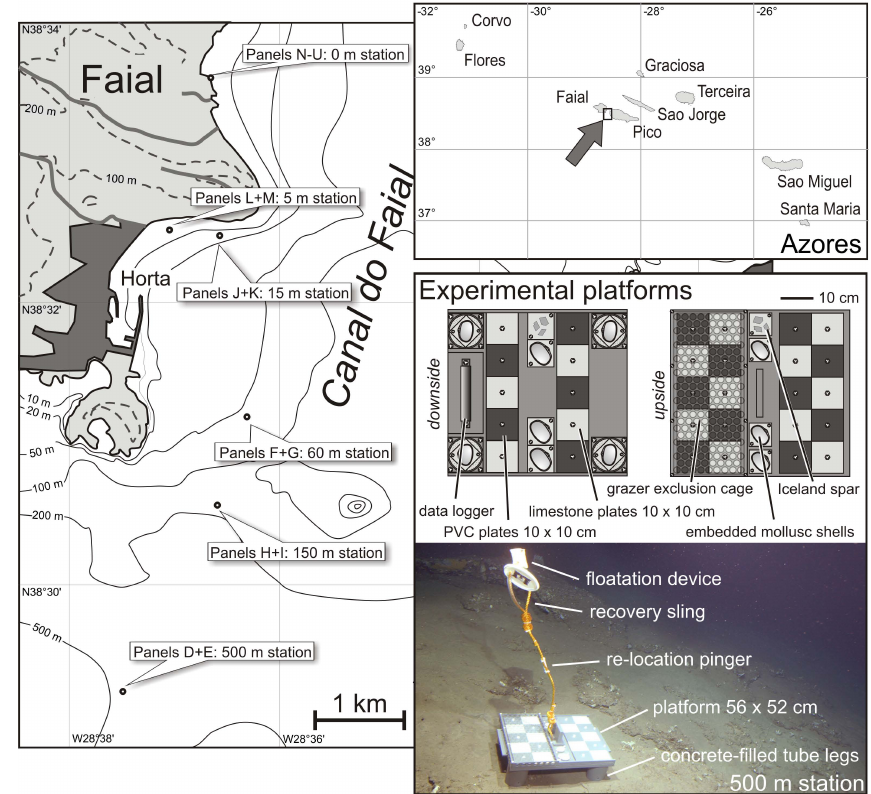
Fig. 1. The bathymetrical transect from the intertidal to 500m water depth in the southern Faial Channel (left) located between the islands of Faial and Pico of the central Azores Archipelago (upper right), and the design of the experimental platforms (lower